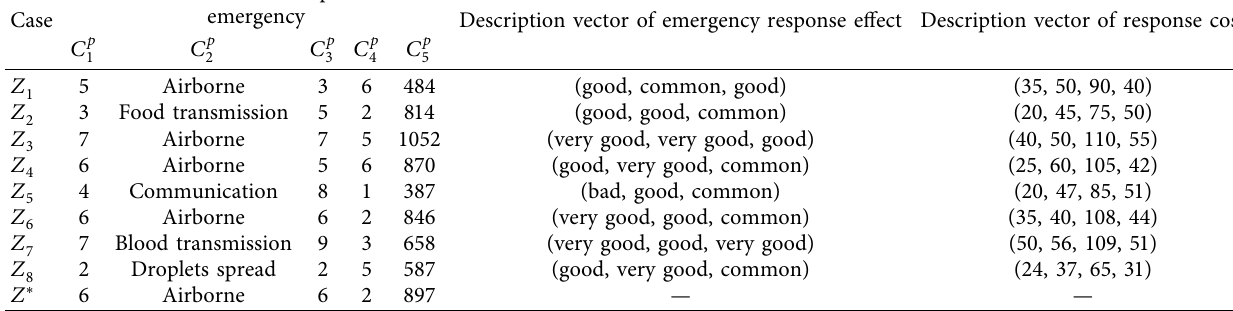
Table 1: Public health emergency problem characteristics, emergency response effect, and response cost.